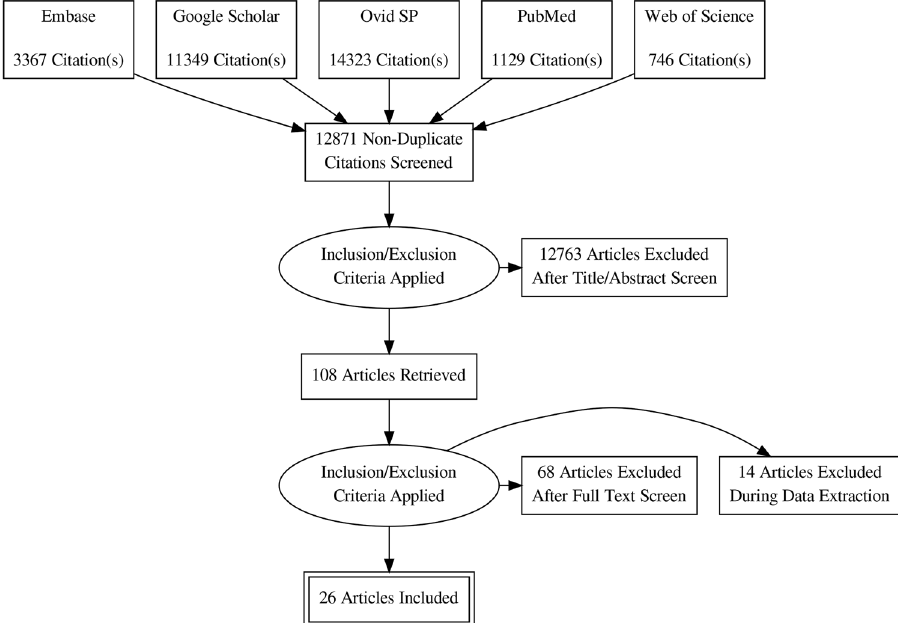
Figure 1. A flowchart of study screening and selection process.